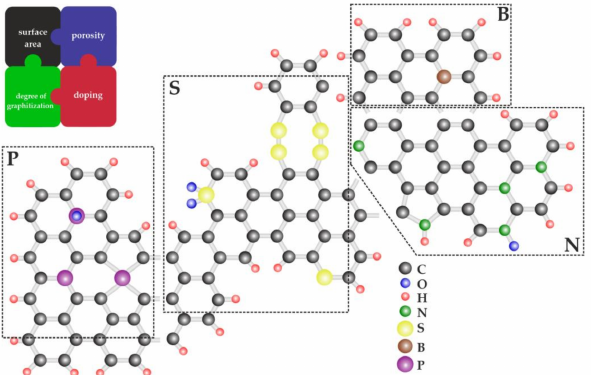
Figure 6. Cartoon illustrating the concept of doping of carbons with heteroatoms resulting in the presence of surface functional groups, as well as emphasizing the importance of carbon porosity, surface area, and the degree of